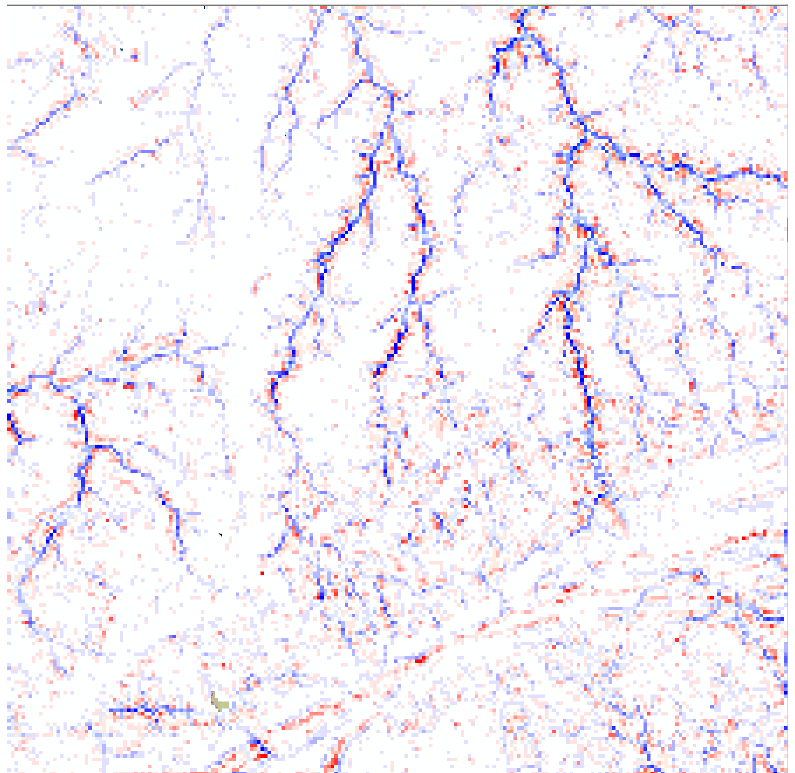
Figure A6. Terrain complexity analysis for the Roc’h Trevezel using TPI metrics. This shows remarkable landform splits in the North–South direction. This provides critical references for network deployment aiming at enhancing the system robustness and range and reducing the cost as